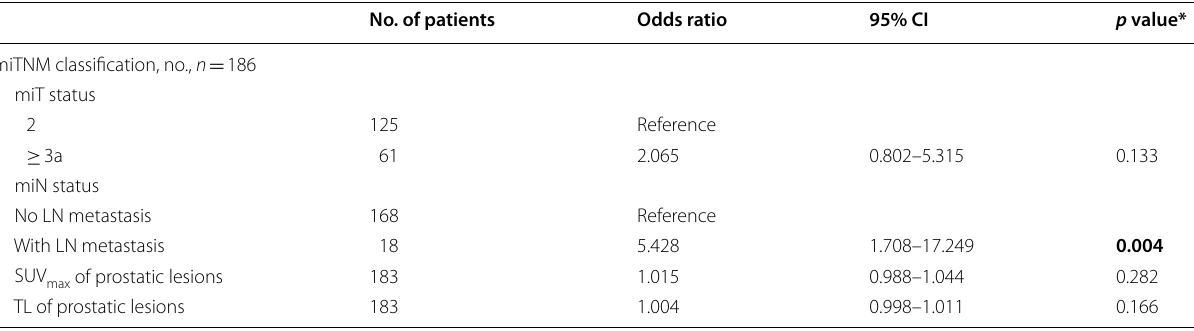
Table 4 Multivariate analysis for the association of 68 Ga‑PSMA‑11 PET findings with surgical margin